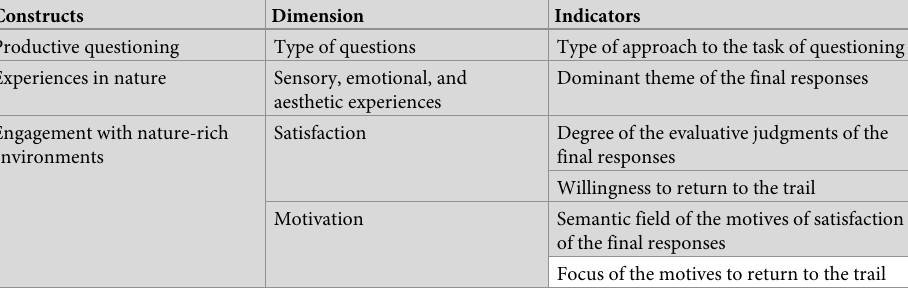
Table 1. Analytical model of the CP technique’s